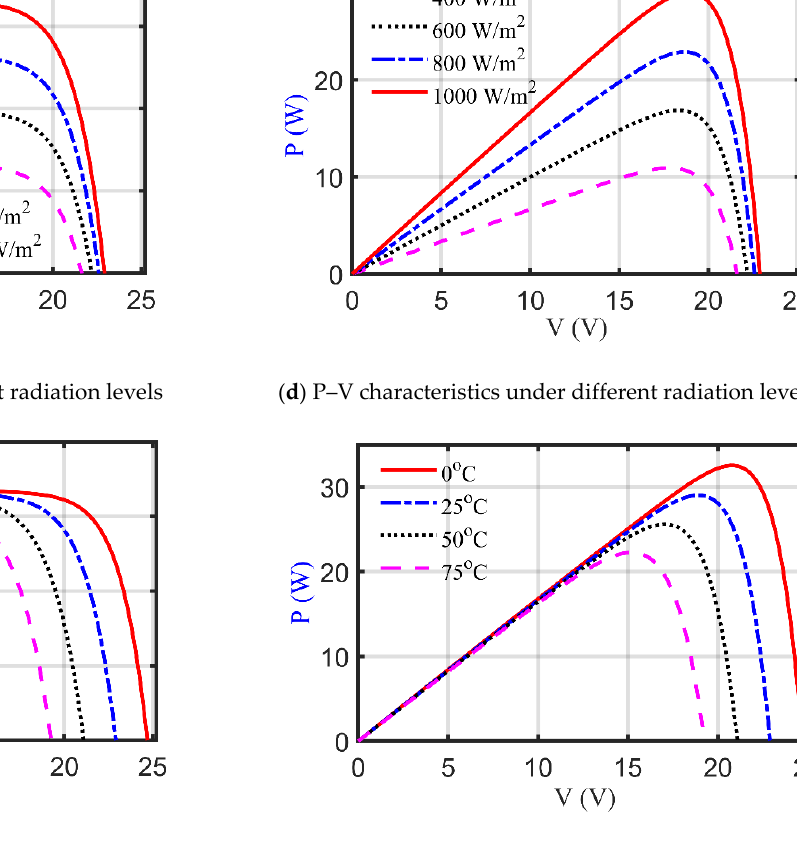
Figure 9. Principal characteristics of STM6-40/36PV module.